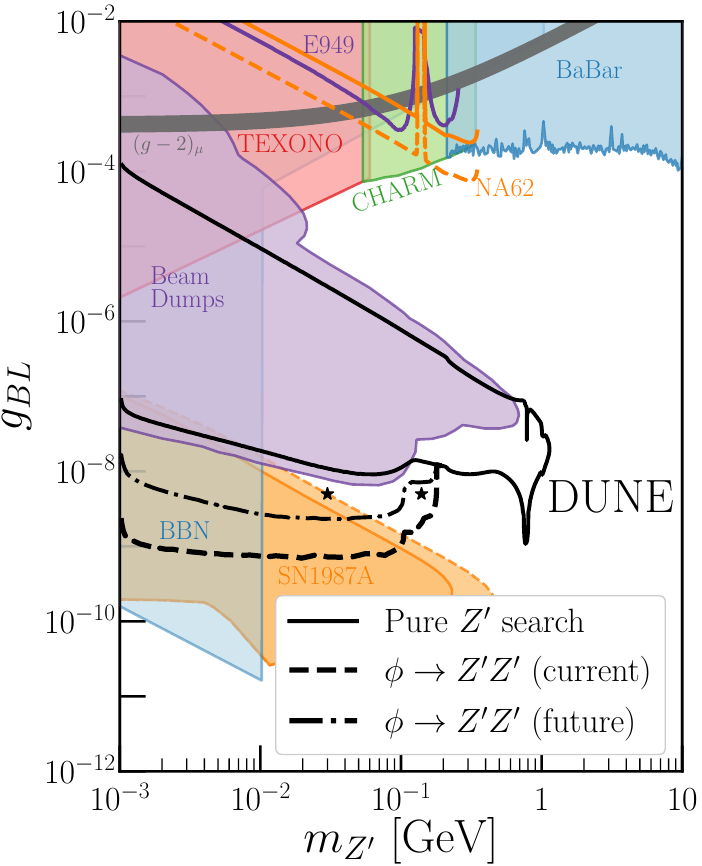
Figure 7 . Improvements of the Z 0 prospects at DUNE near detector complex as a result of the new channel ϕ → Z 0 Z 0 . The dashed line indicates the improvement if we only subject ϕ and sin 2 ϑ to current constraints from CHARM, KOTO, NA62, and E949 (see section 3.2.2), where the dot- dashed line also includes constraints from DUNE’s direct search for ϕ . Between the dot-dashed and dashed lines, any Z 0 signal in DUNE should also require a direct ϕ signal in the same data. All other constraints and labels are the same as in figure